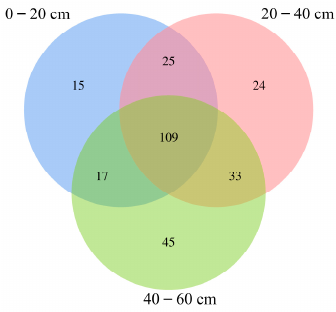
Figure 2. Venn diagram of node distribution of bacterial molecular ecological network in three soil layers.